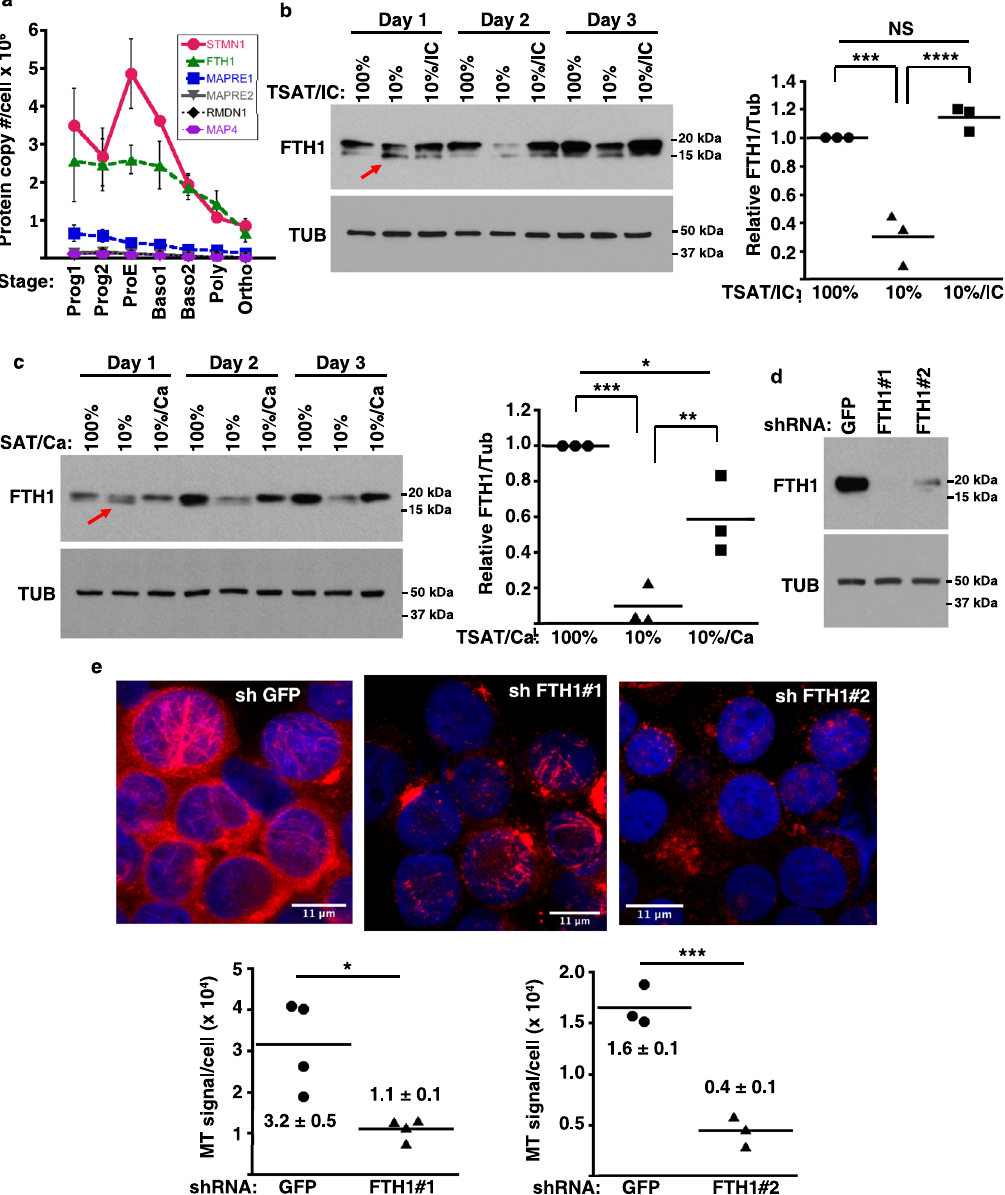
Fig. 3 FTH1 as a microtubule-stabilizing factor controlled by iron and isocitrate. a Levels of major microtubule-associated proteins (MAPs) in erythroid cells cultured from human CD34 + progenitors, from proteomic data of Gautier 18 . Graph: mean protein copy number per cell for fi ve most abundant MAPs at indicated stages of differentiation. Red: Stathmin 1 (STMN1); green: ferritin heavy chain (FTH1); blue: microtubule-associated protein RP/EB family member 1 (MAPRE1); grey: microtubule-associated protein RP/EB family member 2 (MAPRE2); black: regulator of microtubule dynamics protein 1 (RMDN1); purple: microtubule-associated protein 4 (MAP4). Stages: progenitor 1 (Prog1), progenitor 2 (Prog2), proerythroblast (ProE), basophilic erythroblast 1 (Baso1), basophilic erythroblast 2 (Baso2), polychromatophilic erythroblast (Poly), and orthchromatic erythroblast (Ortho). Error bars, SEM; n = 3 biologically independent replicates for Prog1 and Prog2, and four biologically independent replicates for all other stages. b FTH1 levels by immunoblot on whole cell lysates from human CD34 + progenitors cultured 1 – 3 days in iron-replete (100% TSAT) or de fi cient (10% TSAT) erythroid medium ± isocitrate (IC). Red arrow: lysosomal proteolytic fragment. Graph: mean normalized FTH1 signal (day 2), relative to value with 100% TSAT. Error bars, SEM; n = 3 independent experiments; ***, **** P = 0.0008, 0.0003, one-way ANOVA with Tukey post hoc. c FTH1 levels by immunoblot on human CD34 + progenitors cultured 1 – 3 days in iron-replete or de fi cient erythroid medium ± protease inhibitor (5 µ M CA074-me). Red arrow: proteolytic fragment. Graph: mean normalized FTH1 signal (day 2), relative to value with 100% TSAT. Error bars, SEM; n = 3 independent experiments; *, **, *** P = 0.028, 0.013, 0.0006, one-way ANOVA with Tukey post hoc. d FTH1 knockdown with lentiviral shRNA. Immunoblot of transduced human CD34 + progenitors cultured 3 days in iron-replete erythroid medium. e Microtubule alterations demonstrated by immuno fl uorescence on cells as in d . Red: β -tubulin; blue: DAPI. Graphs: microtubule (MT) density, re fl ected as averaged microtubule signal per cell in arbitrary units. Numbers indicate mean ± SEM; n = 4 independent experiments for assessment of FTH1#1 and three independent experiments for assessment of FTH1#2; *, *** P = 0.029, 0.0014, unpaired two-sided Student ’ s t test. Note: most experiments separately assessed FTH1#1 and FTH1#2. See also Supplementary Figs. 5 – 7 and Supplementary Data Table 1. Source data are provided as a Source data fi